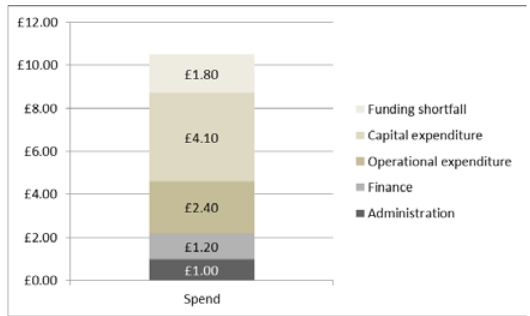
Figure 3. Metronet’s project spend as of July 2007. Source: Own elaboration based on NAO (2009, p. 17). The first period runs from April 2003 to October 2007 (7.5